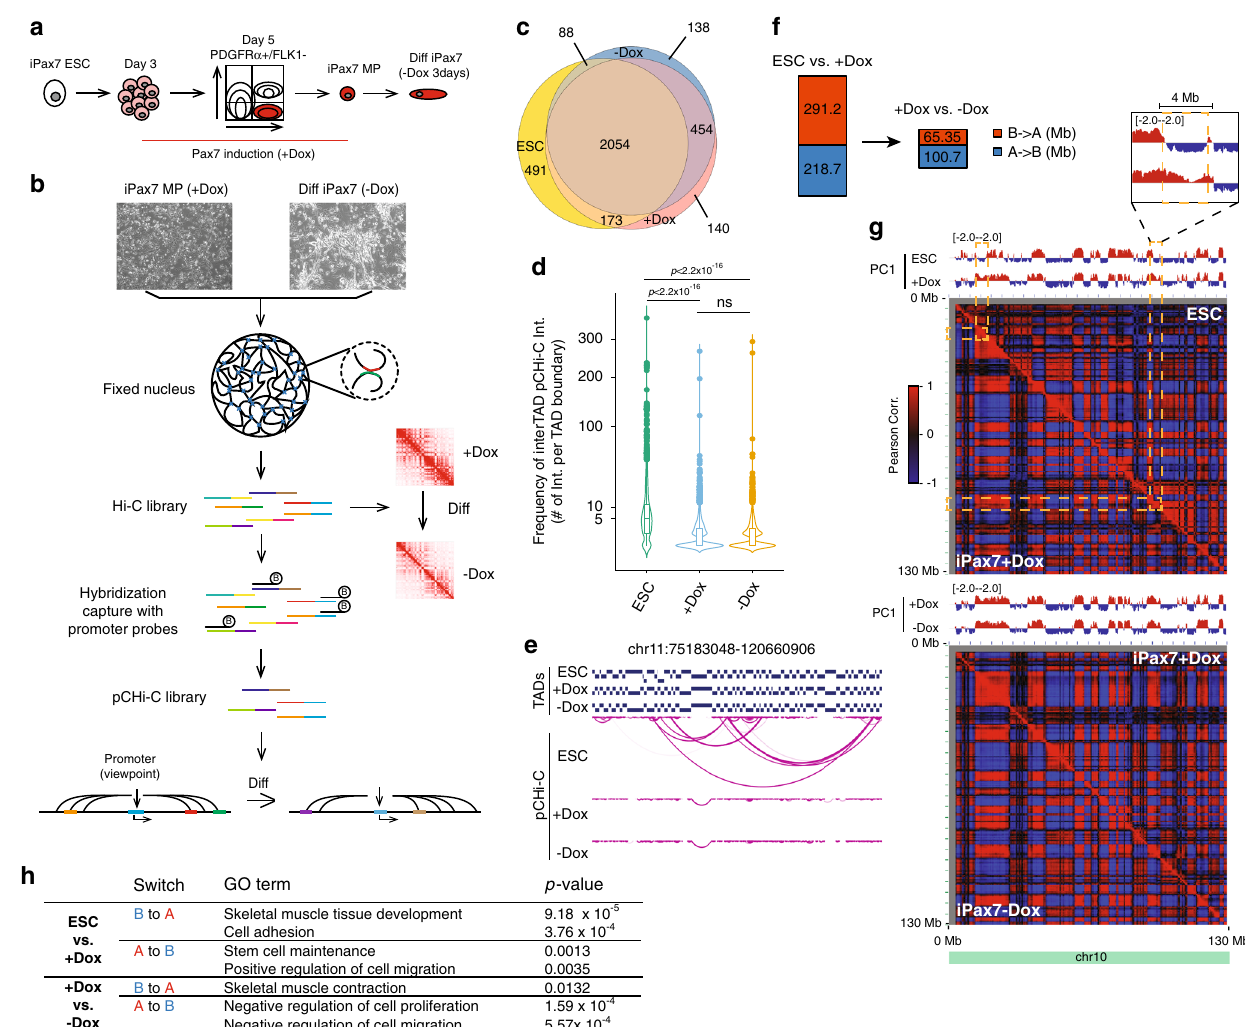
Fig. 1 Global chromatin conformational changes during muscle cell progenitor speci fi cation and differentiation. a Scheme for the generation of iPax7 skeletal muscle progenitors (MP) and differentiated derivatives (Diff). b Scheme showing experimental design to generate genome-wide Hi-C and pCHi-C maps in undifferentiated ( + Dox) and differentiated ( − Dox) iPax7 cells. c Venn diagram showing overlap of TADs identi fi ed in ESC, iPax7 + Dox, and iPax7 − Dox populations. d Violin plot showing the frequency of signi fi cant inter-TAD interactions identi fi ed by pCHi-C at each TAD boundary in ESCs ( n = 2816) and iPax7 ( + Dox ( n = 2821) and – Dox ( n = 2734)) cells. The boxplot within each violin plot shows the 25th and 75th percentile (bottom and top of box), and median value (horizontal band inside box). The whiskers indicate the values observed within up to 1.5 times the interquartile range above and below the box. Statistical signi fi cance tested with two-tailed Student ’ s t -test. e Representative example of a genomic region with high-con fi dence inter- TAD pCHi-C interactions primarily observed in ESCs but not iPax7 cells. Each magenta arc depicts a high-con fi dence pCHi-C interaction. f Quanti fi cation of genome-wide compartment switches from B to A (red) and A to B (blue) for ESCs vs. + Dox iPax7 and + Dox vs. − Dox iPax7 populations. Switches are quanti fi ed in Mb. g Compartment changes at chr10 for ESCs vs. iPax7 + Dox (top) and iPax7 + Dox vs. iPax7 − Dox (bottom). PC1 value tracks (red: positive values; blue: negative values) and Pearson correlation matrices for the intra-chromosomal interaction pro fi les were generated at 500 kb resolution for comparison. Selected regions showing compartmental switching are highlighted with yellow dashed rectangles. h GO analysis of select groups of genes located in compartments altered when comparing ESCs vs. + Dox iPax7 cells and + Dox vs. − Dox iPax7